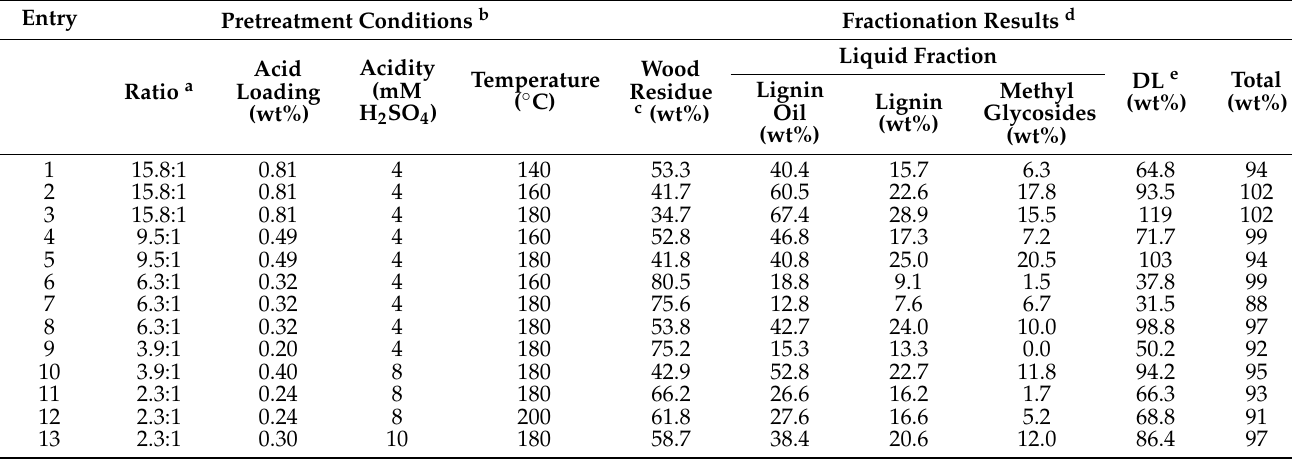
Table 1. Fractionation by acid methanolysis of birchwood as a function of the methanol/biomass ratio, temperature, pressure and acid